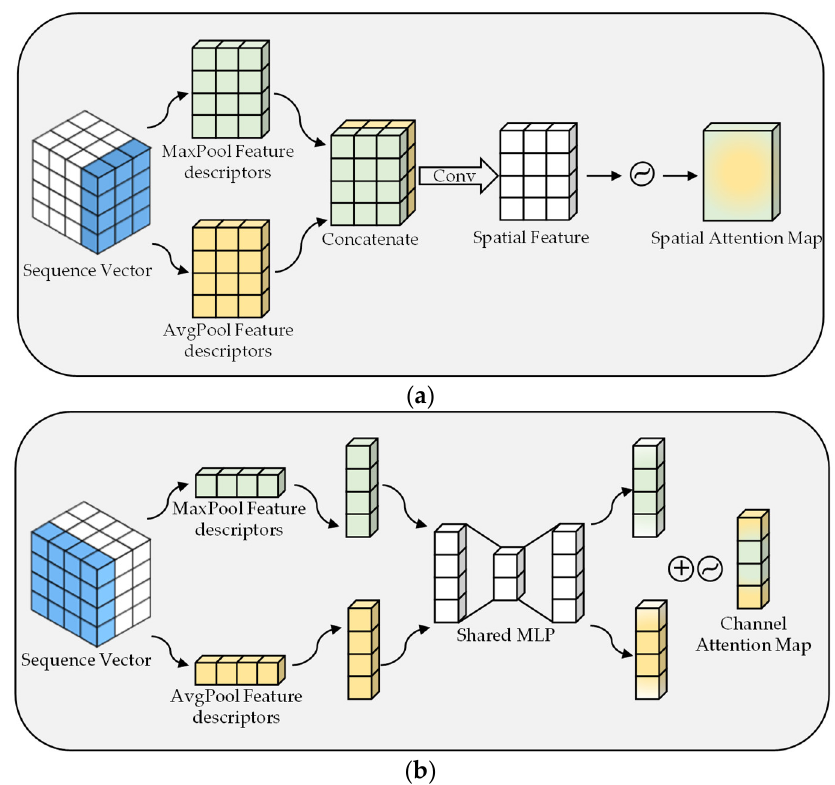
Figure 5. The extraction framework diagram of spatial aention map and channel aention map. ( a ) The extraction framework of spatial aention map. ( b ) The extraction framework of channel aen- tion map.